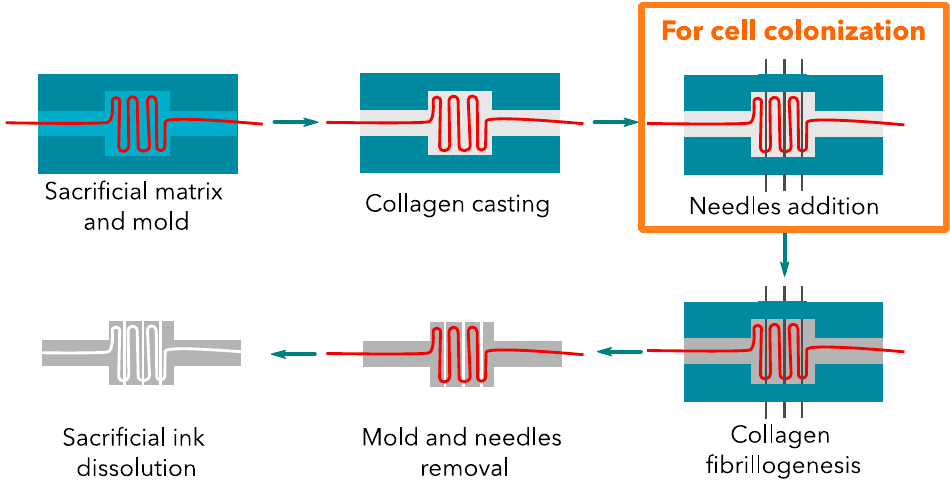
Figure 2. Collagen construct development. The addition of needles is only required for cellularized constructs. These large channels were filled with cells. Three needle-molded (23 G) channels were added at 500 µm above the perfusion channel for cellularized constructs. These channels were then filled with cells.